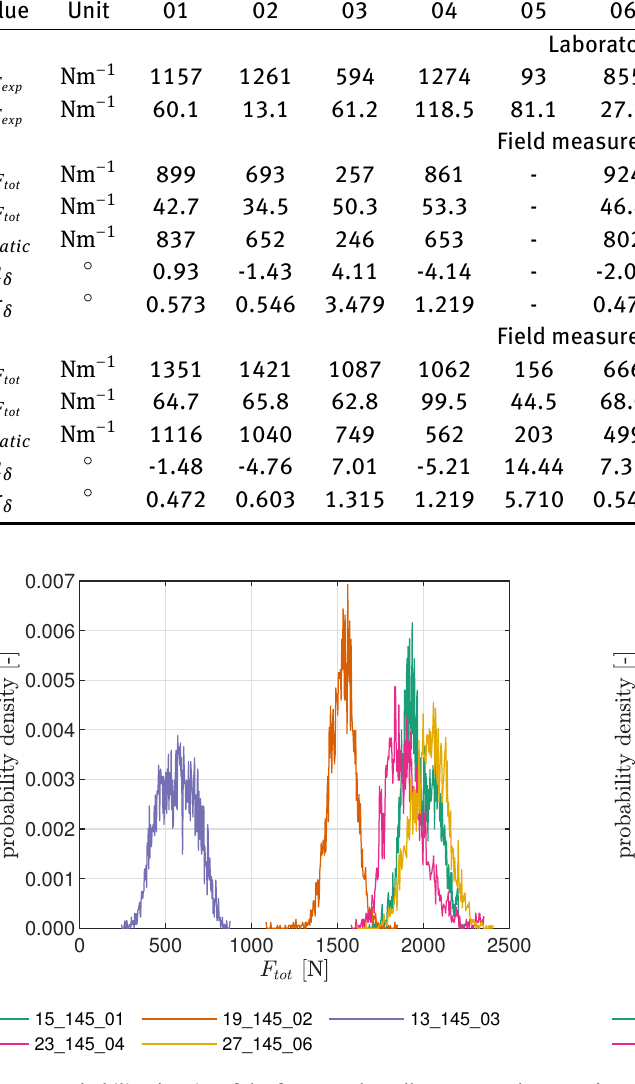
Figure 9: Probability density of the force on the rollers on panel 145 carrying strain.